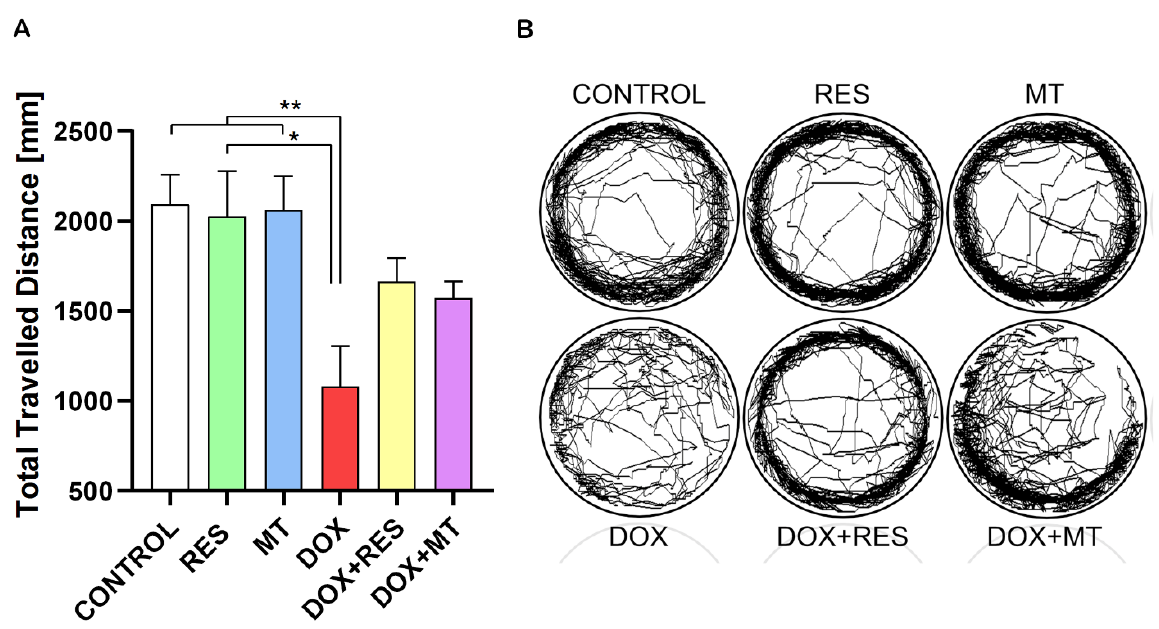
Figure 10. Effect of doxorubicin on locomotor activity of zebrafish post-larvae. Ctsk reporter zebrafish transgenic line ( Tg(ctsk:DsRed )) were exposed to different concentrations of resveratrol (RES), MitoTEMPO (MT) alone or together with doxorubicin (DOX) for 24 h. Locomotor activity was measured on Zantiks MWP system. Total distance travelled with RES (100 µM), MT (20 µM) and DOX (17.2 µM) alone or together ( A ). The locomotory pattern of fish between the treatment groups ( B ). One-way ANOVA, Tukey’s multiple comparisons test, *— p ≤ 0.05, **— p ≤ 0.01.